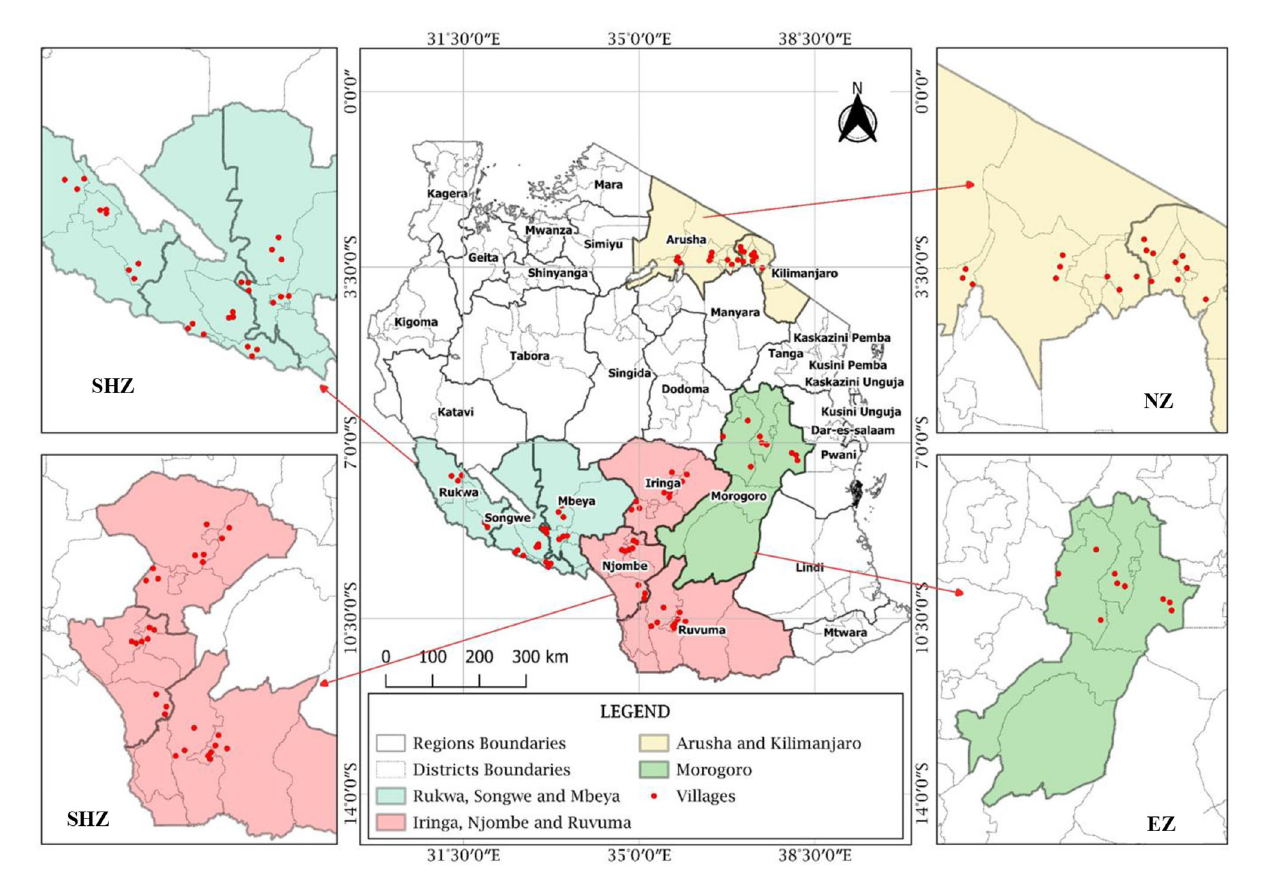
FIGURE2 Map showing nodules sampling fields in different regions of Tanzania (SHZ-Southern Highland Zone, EZ-Eastern Zone, and NZ-Northern